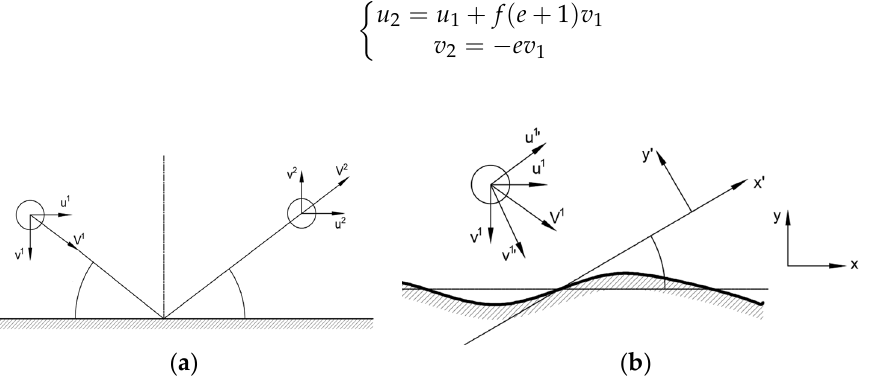
Figure 4. Collision process between rapeseeds and wall surface. ( a ) Collision with smooth wall; ( b ) collision with convex wall.